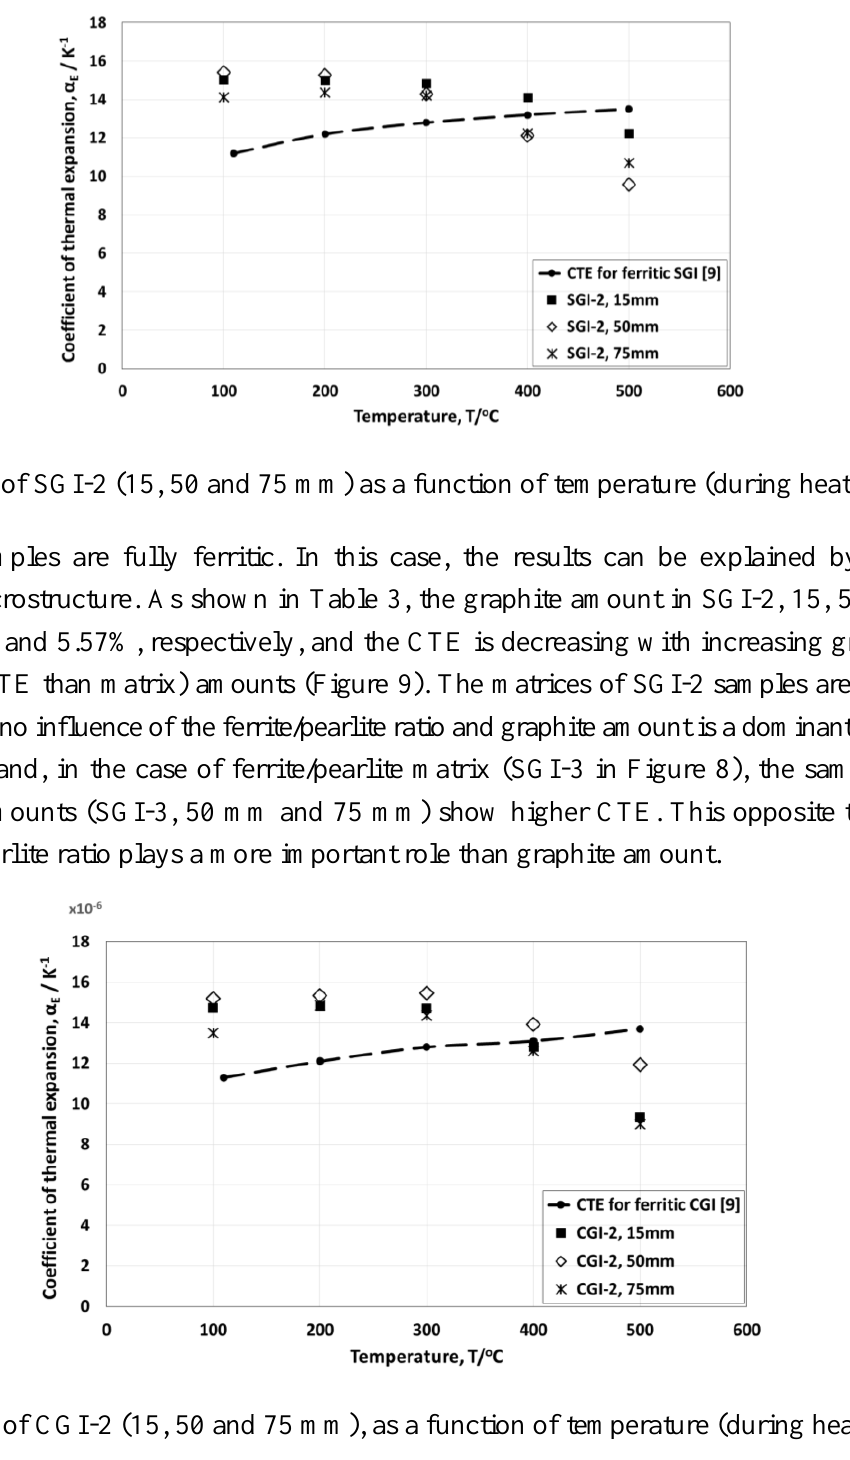
Figure 10. CTE of CGI-2 (15, 50 and 75 mm), as a function of temperature (during heating cycles). The graphite amount in CGI-2, 15, 50 and 75 mm, are almost the same (about 2%) and it seems there is no relation between nodularity and CTE (Figure 10). The CTE of the SGI and CGI cast irons are summarized in Figure